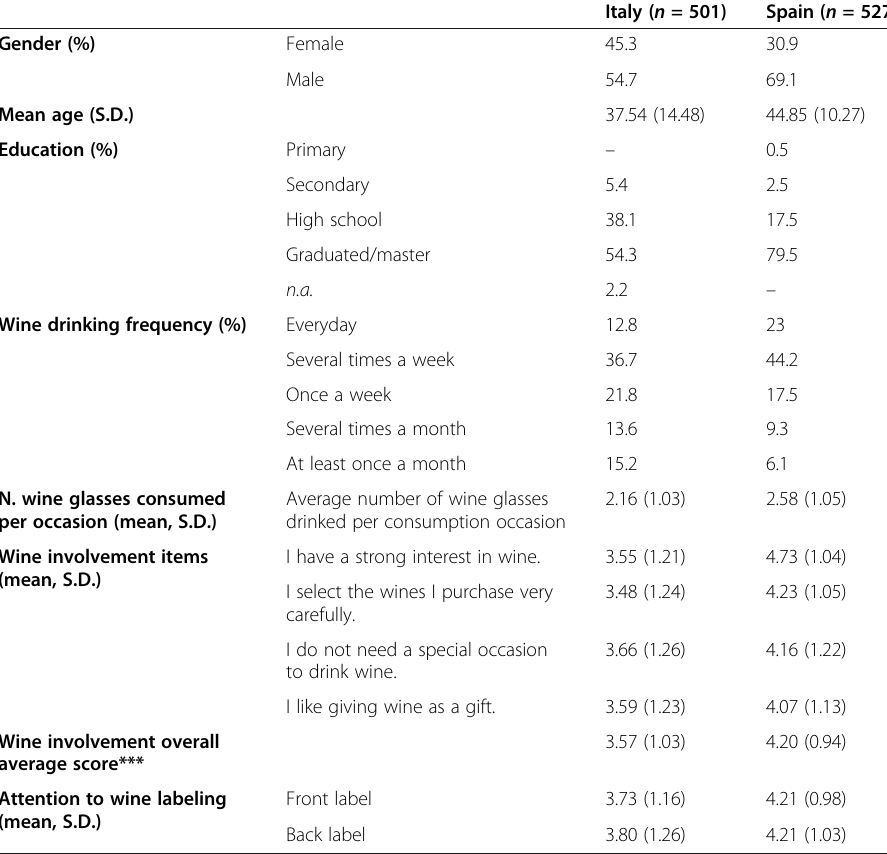
Italy ( n = 501) Spain ( n = 527)